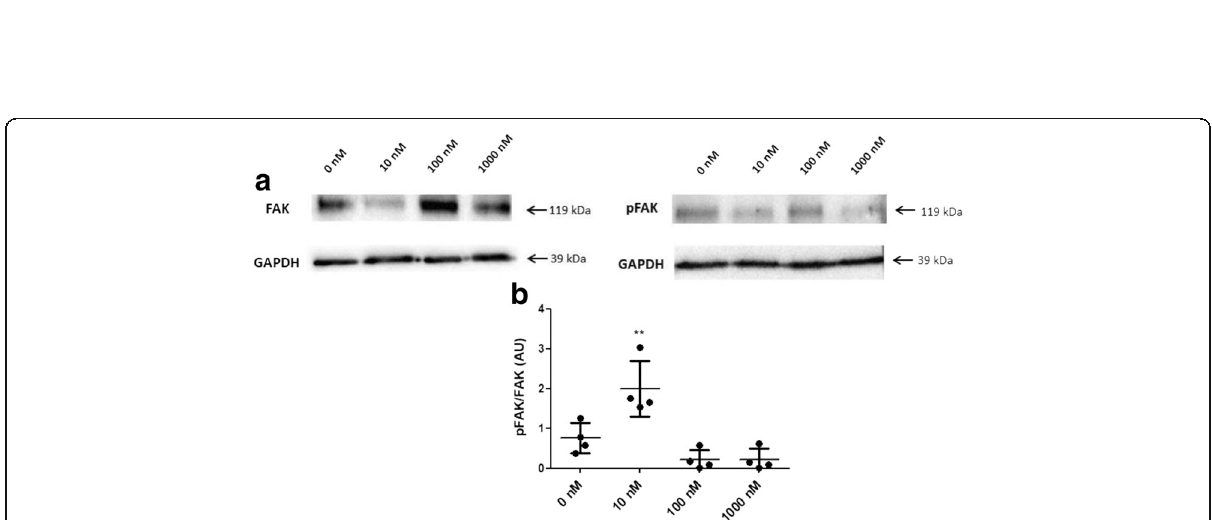
Fig. 6 ALT-C induces FAK phosphorylation at 10 nM but not at 100 and 1000 nM. a FAK and p-FAK protein level revealed by Western blotting in lysates extracted from MDA-MB-231 treated with ALT-C (10, 100 and 1000 nM) and control (0 nM). b Values represent the normalized densitometry ratio of p-FAK and FAK and the p value was determined using ANOVA followed by Tukey ’ s test. Values were also previously normalized to the level of GAPDH densitometry. ** p <0.01 compared to control (0 nM). The assay was performed in independent assays ( n =2) and Western blotting in